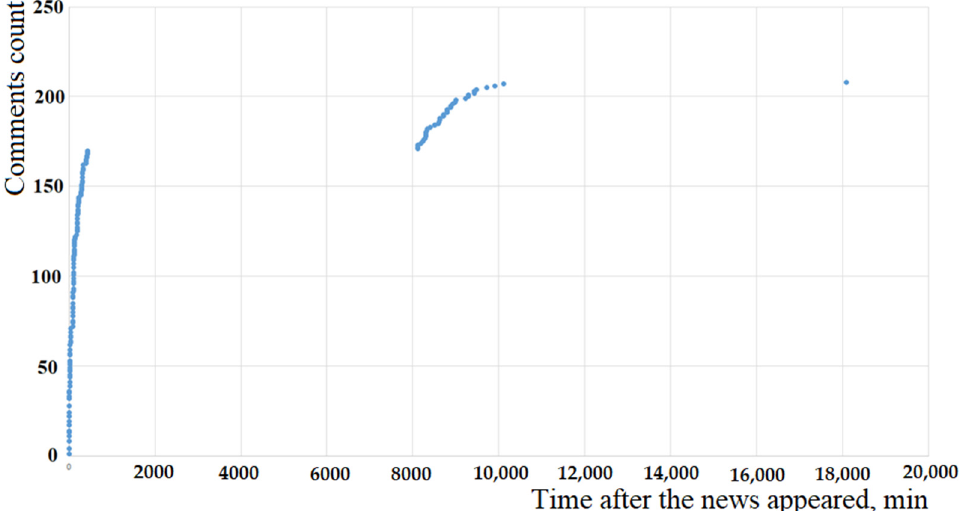
Figure 9. The observed dynamics of change over time, the number of comments on a news item of public interest that appeared on the portal https://echo.msk.ru/news/2571431-echo.html on